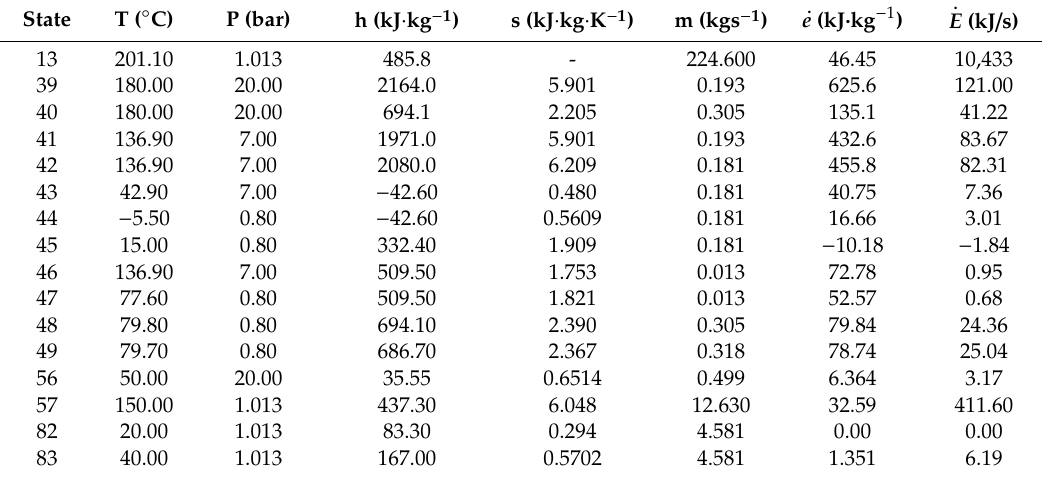
Table A3. Thermodynamic state point properties for the Kalina cycle in the